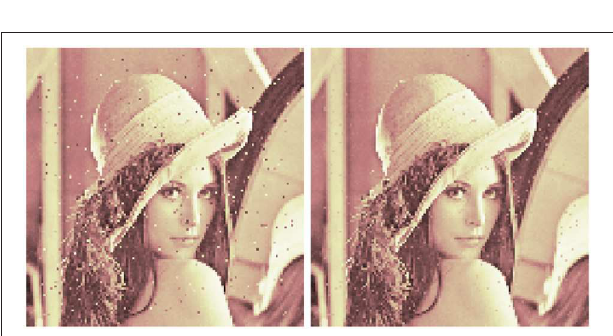
FIGURE 5 | Reconstruction of Lena (see Figure 3 ) using splines of order 2 with random starting guess (left) and mean value strategy (right)